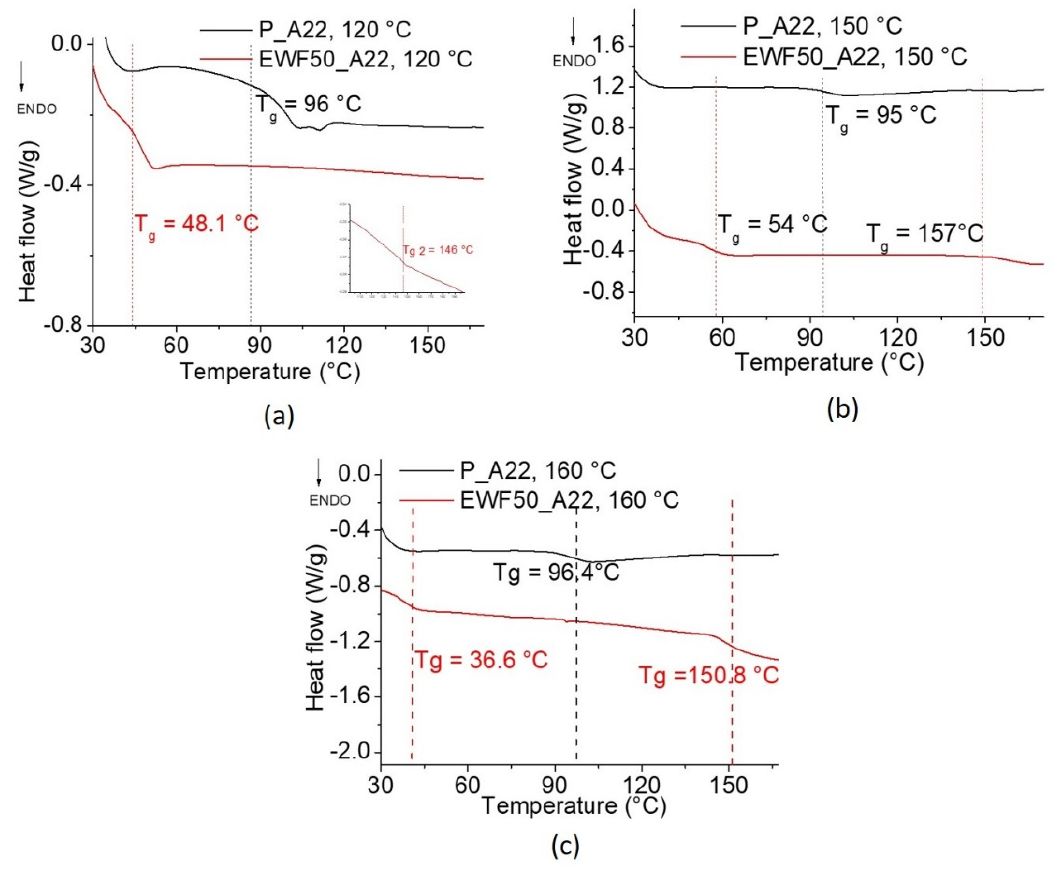
Figure 5. DSC analysis of blends postcured at 120 °C ( a ), 150 °C ( b ), and 160 °C ( c ).